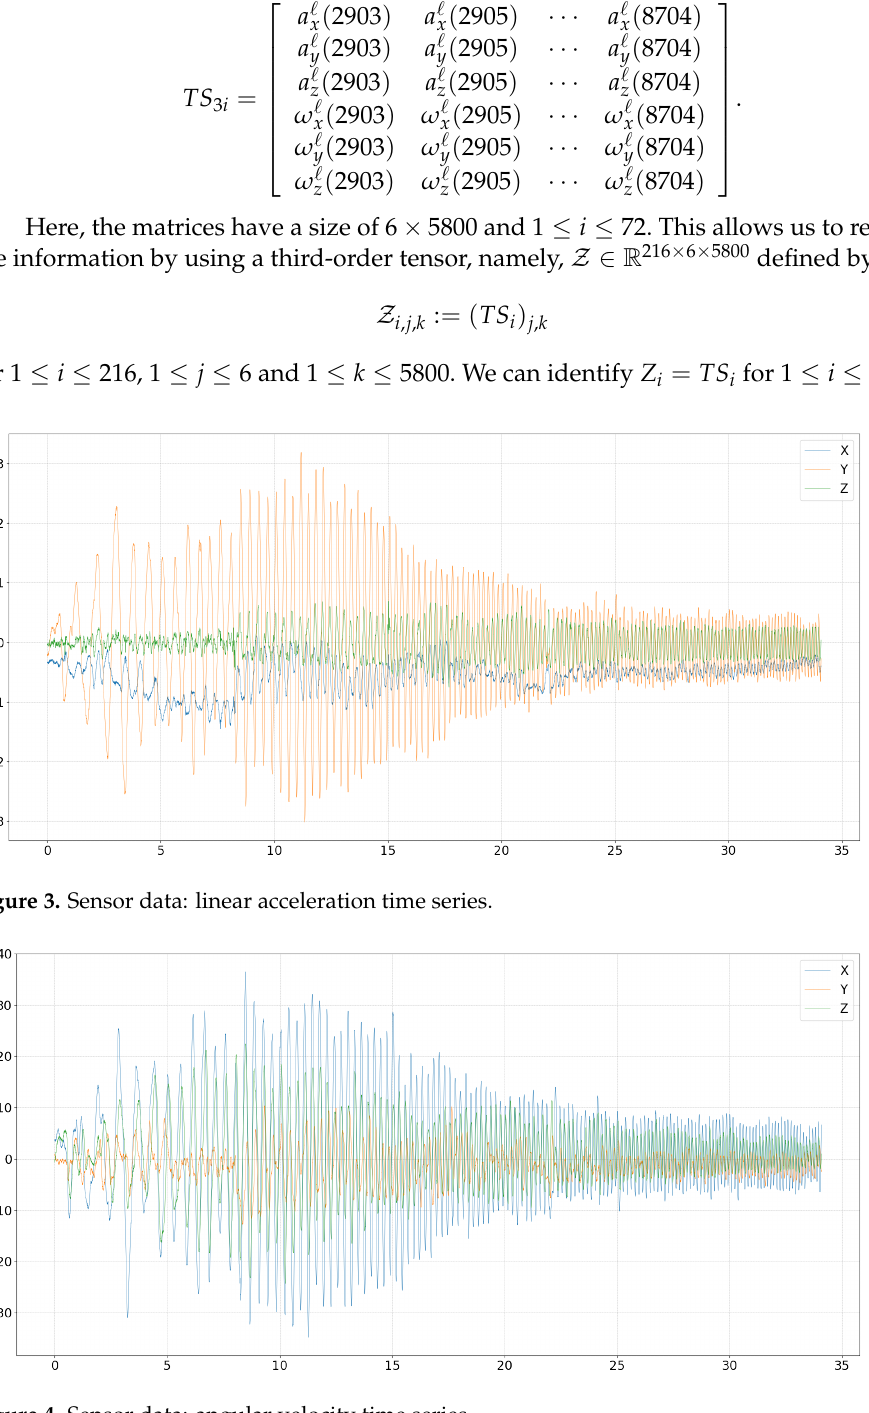
Figure 4. Sensor data: angular velocity time